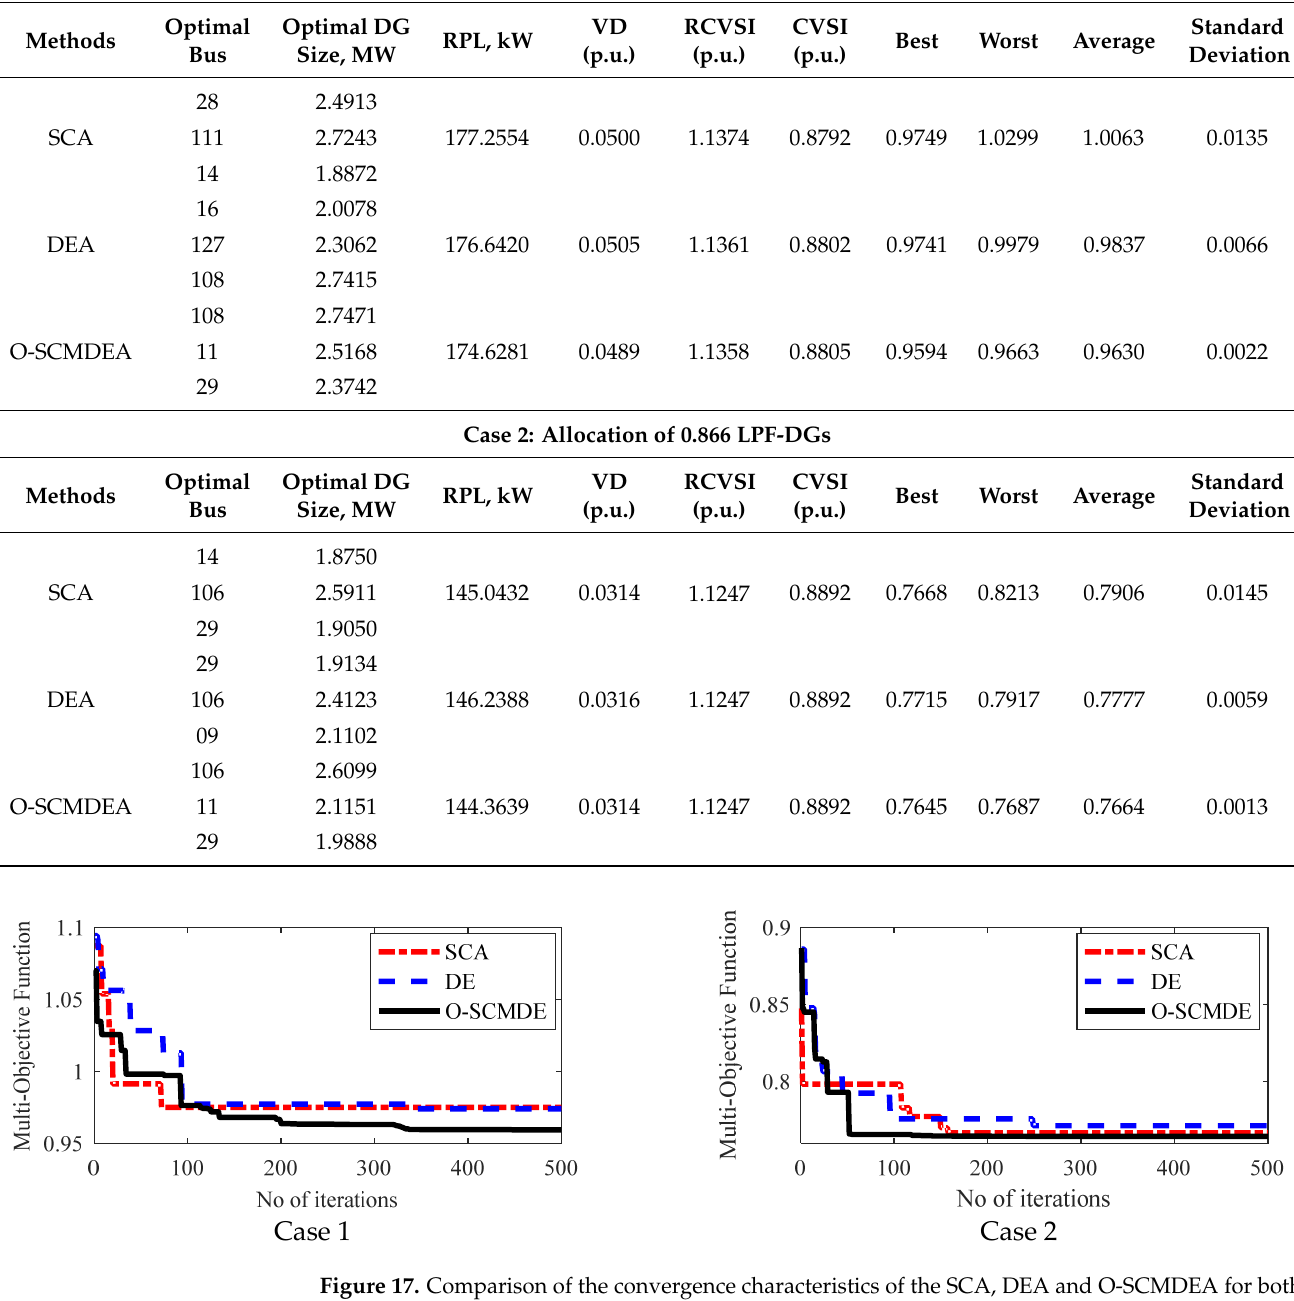
Figure 18. Voltage profile of the 136 bus test system for scenario IV.